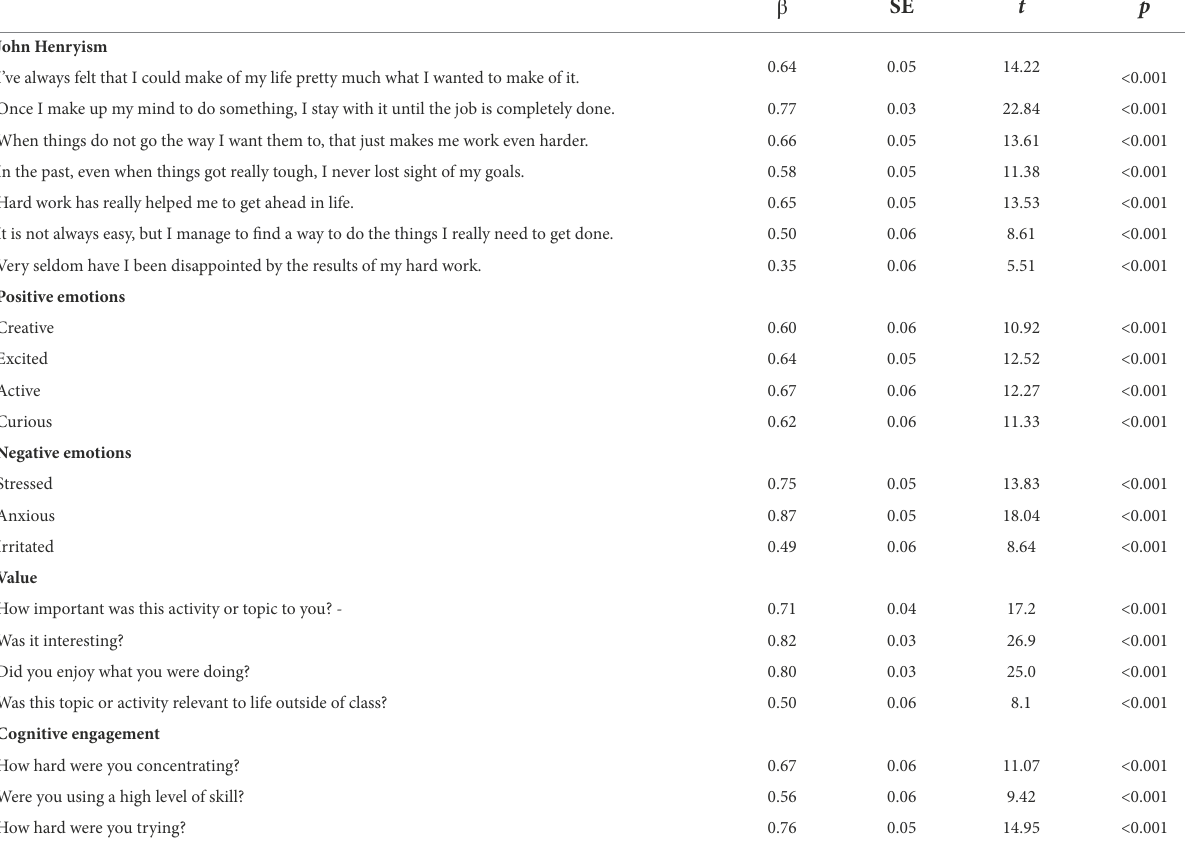
TABLE 3 Confirmatory factor